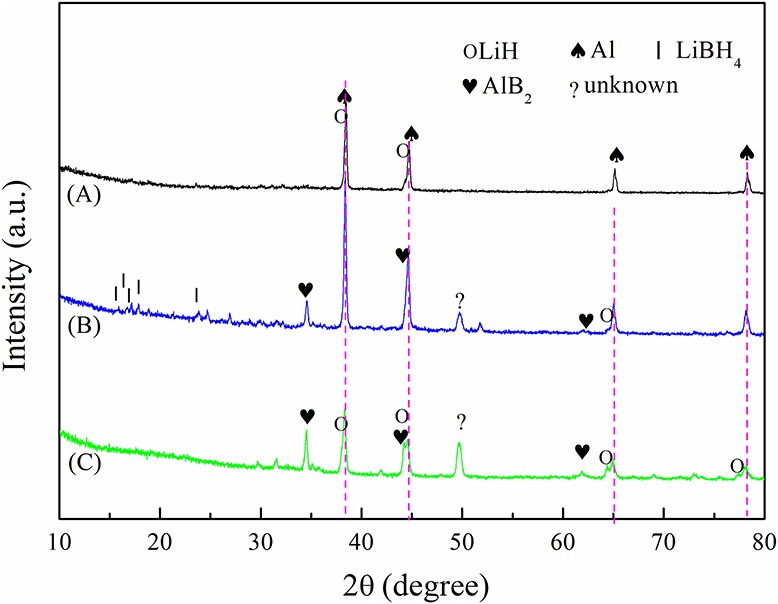
XRD results of dehydrogenated samples at 400°C: (A) 2LiBH4-Al, (B) 2LiBH4-LiAlH4, and (C) 2LiBH4-Li3AlH6.